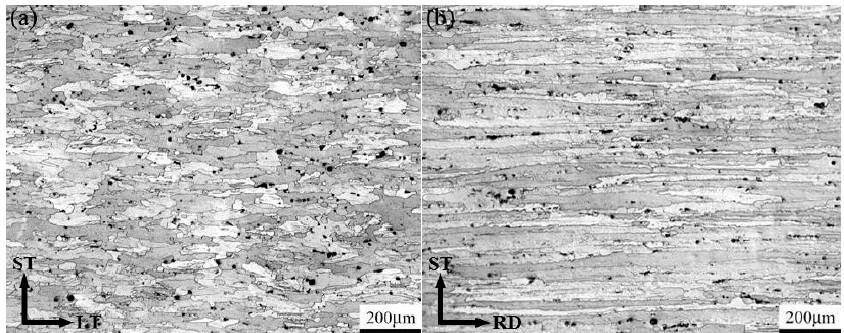
Figure 3. Variation of orientation densities in α and β fibers of the 7050 aluminum alloy ( a ) α fiber; ( b ) β fiber.